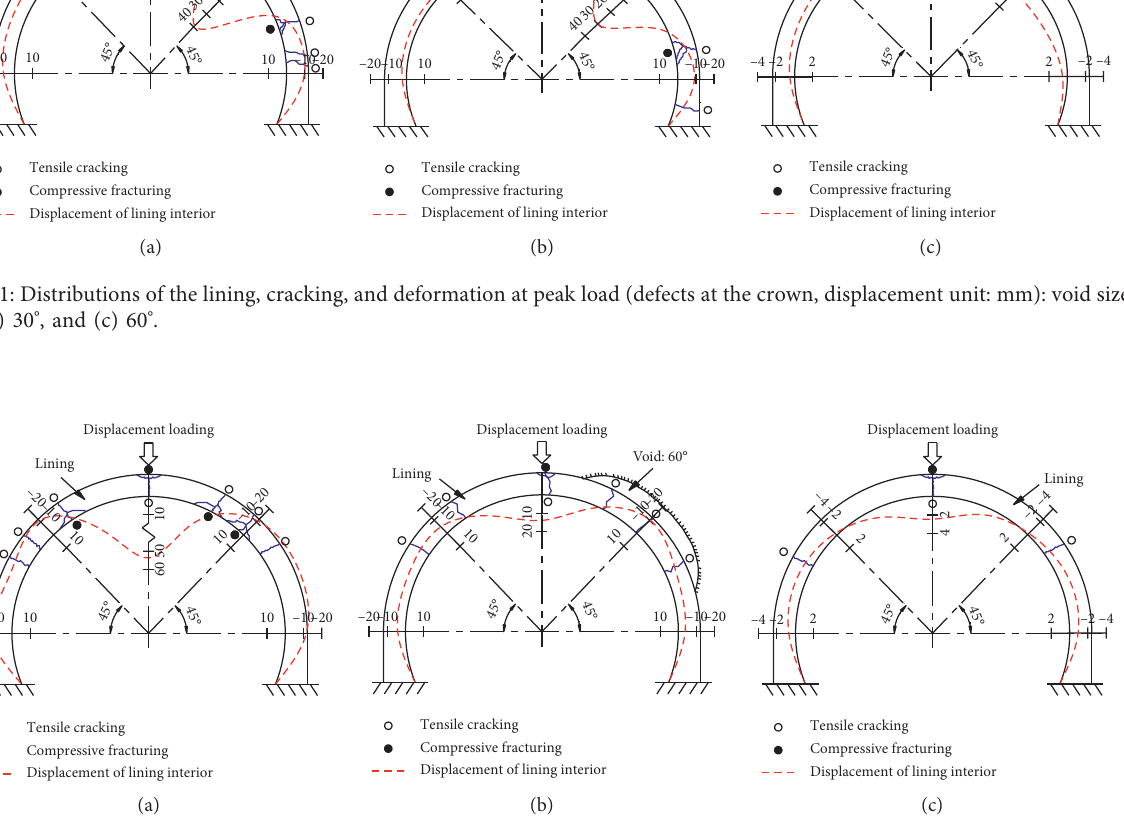
Figure 12: Distributions of the lining, cracking, and deformation at peak load (defects at spandrel, displacement unit: mm): void sizes of (a) 0 ° , (b) 60 ° , and (c) 180 ° .